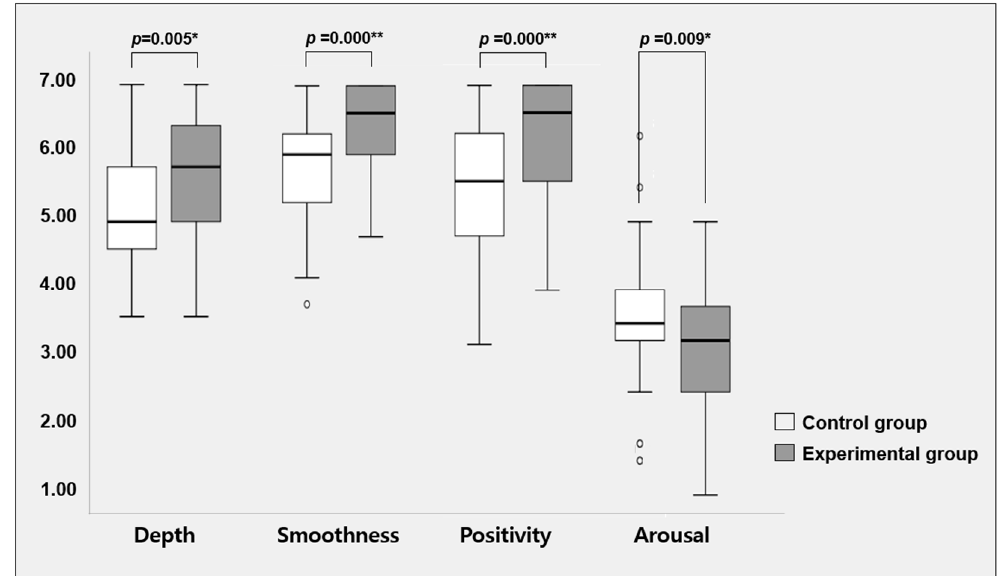
Figure 2. Scores for four subcategories of SEQ. Data are shown as a box and whisker plot. In this plot, whiskers extend to the largest and smallest data points and the box extends from the upper quartile to the lower quartile crossed by a line at the median of data. Subjects in the Experimental group were interviewed by direct care workers who experienced SEE-C. Subjects in the Control group were interviewed by direct care workers who did not experience SEE-C. * Statistically significant at p < 0.01. ** Statistically significant at p < 0.001.